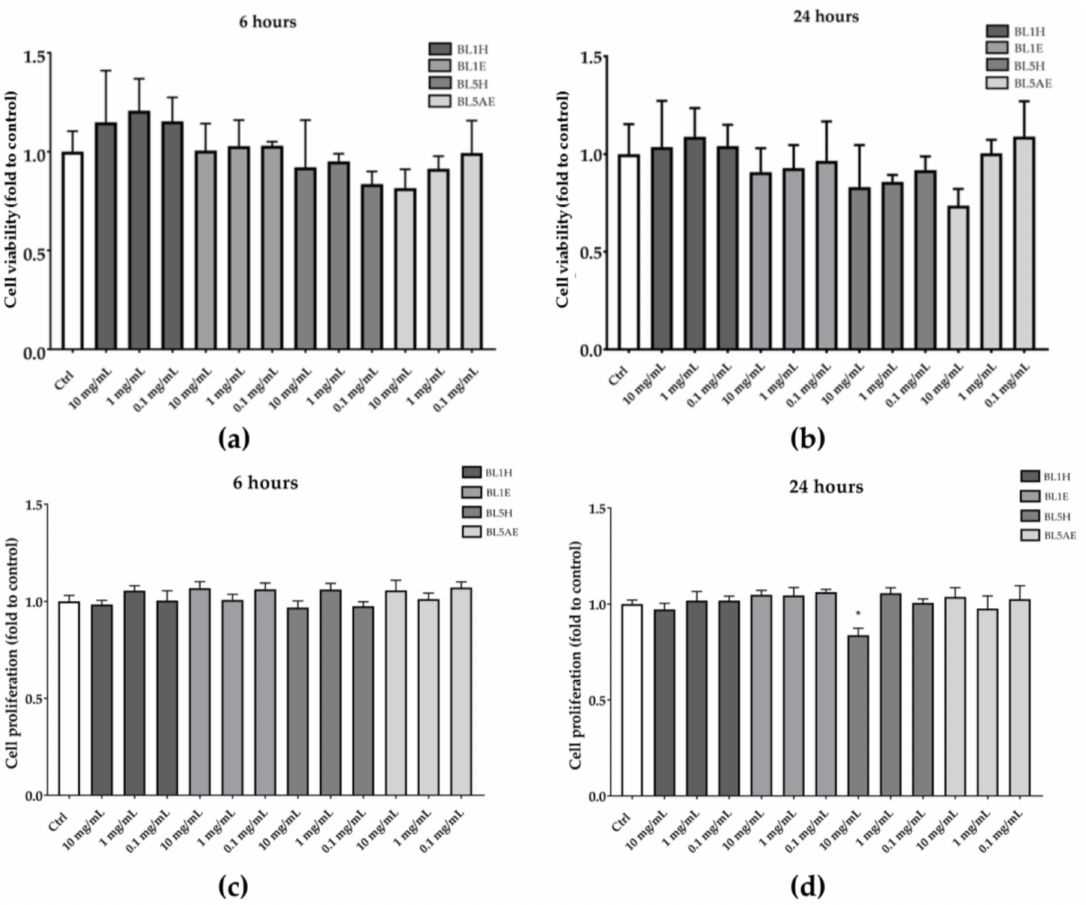
Figure 7. Effects of BL1H, BL1E, BL5H, and BL5AE on cell viability ( a , b ) and cell proliferation ( c , d ). * p < 0.05 vs.